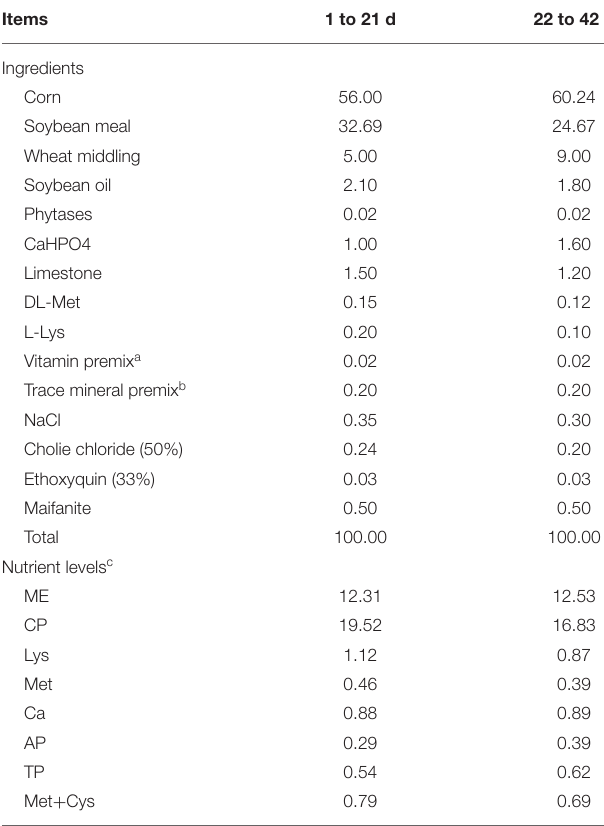
TABLE 1 | Composition and nutrient levels of basal diets (air-dry basis, %).